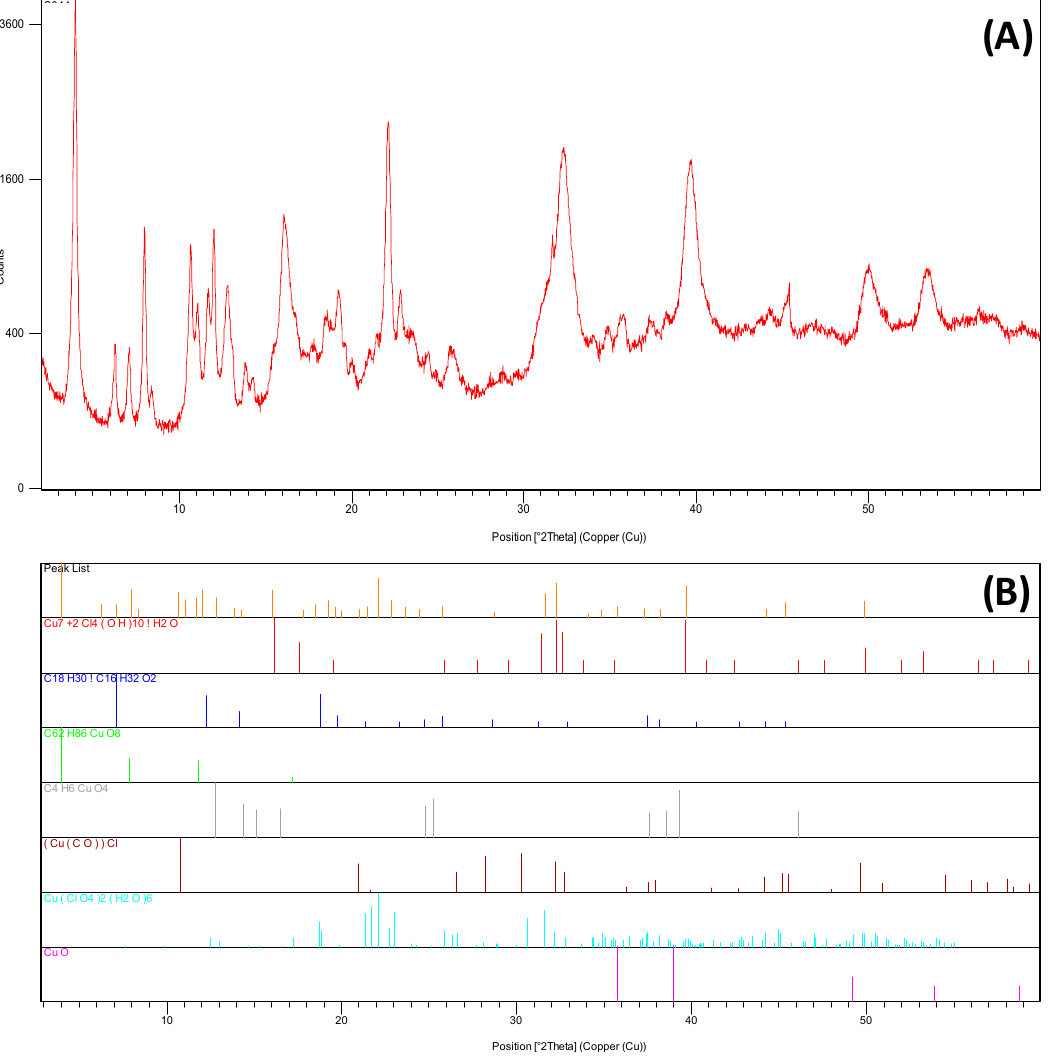
Figure 2. ( A ) XRD pattern of the obtained product, and ( B ) identification patterns of the different species matched.